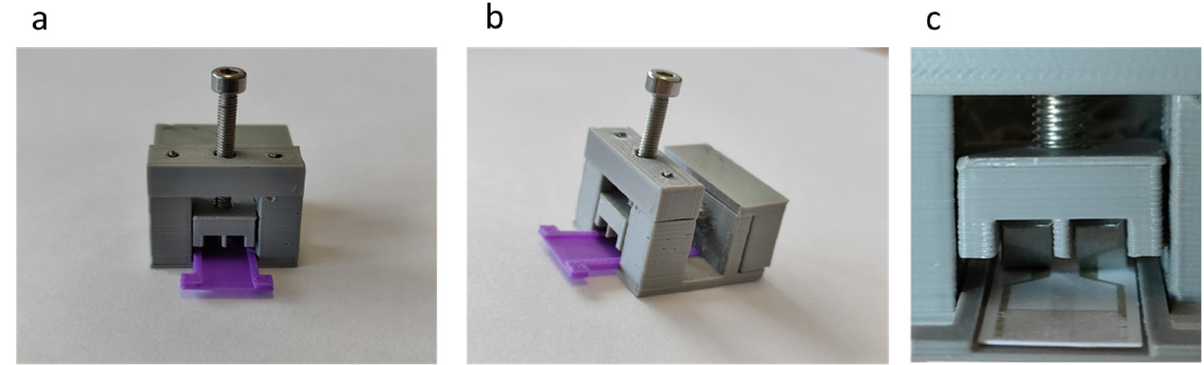
Figure 8. The 3D printed connector: ( a ) front view; ( b ) side view; and ( c ) the connection of the conductive plates to the sensor.